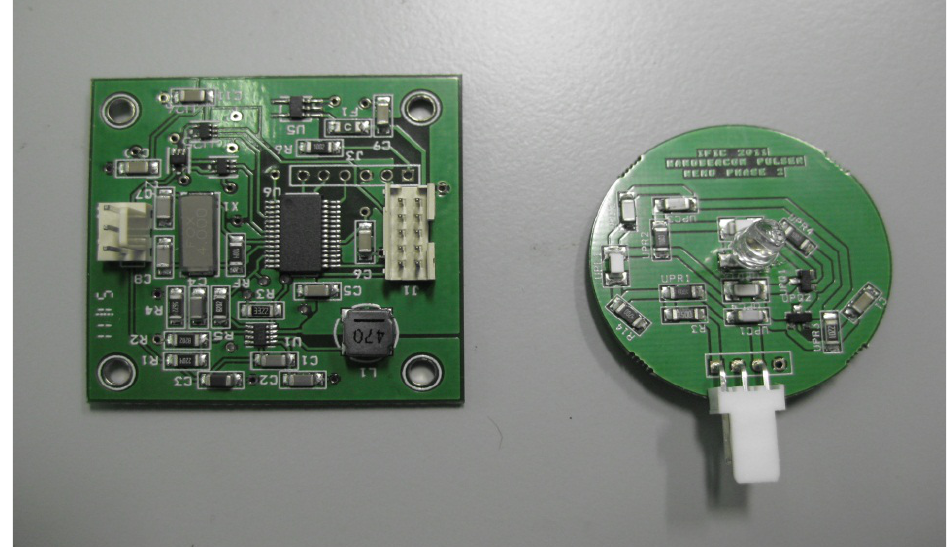
Figure 1. NOPELED Electronics boards: the controller and the